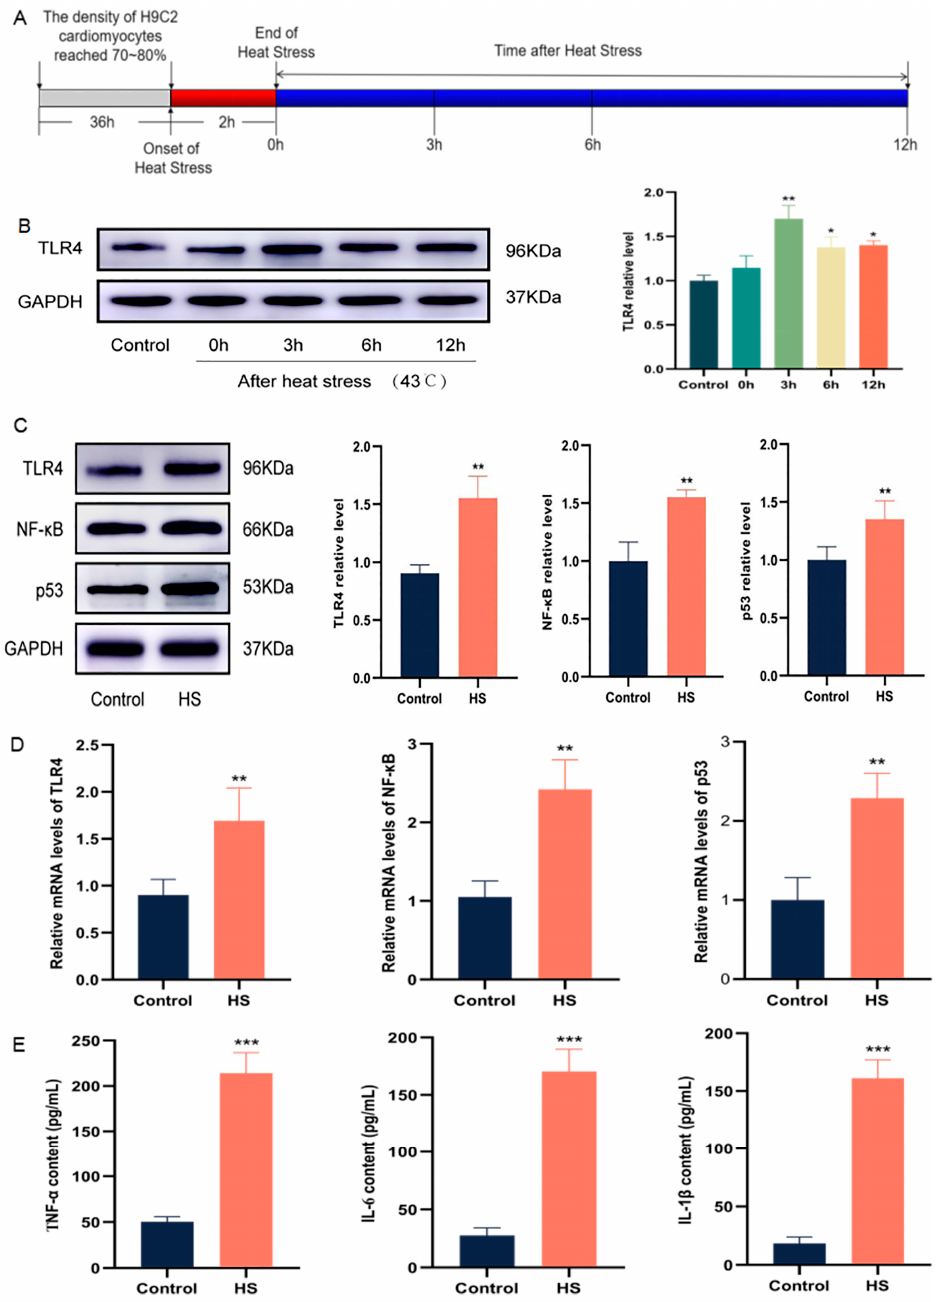
Figure 2. HS activates TLR4/NF- κ B signaling pathway and inflammatory environment. The in vitro experimental protocol ( A ). TLR4 expression levels at different time points after heat exposure ( B ). The protein levels of TLR4, NF- κ B, and p53 after 3 h recovery from heat exposure ( C ). The mRNA levels of TLR4, NF- κ B, and p53 after 3 h recovery from heat exposure ( D ). The levels of TNF- α , IL-6, and IL-1 β after 3 h recovery from heat exposure ( E ). The results were expressed as the mean ± SD deviation of three independent experiments, * p < 0.05, ** p < 0.01, *** p < 0.001 vs. the control